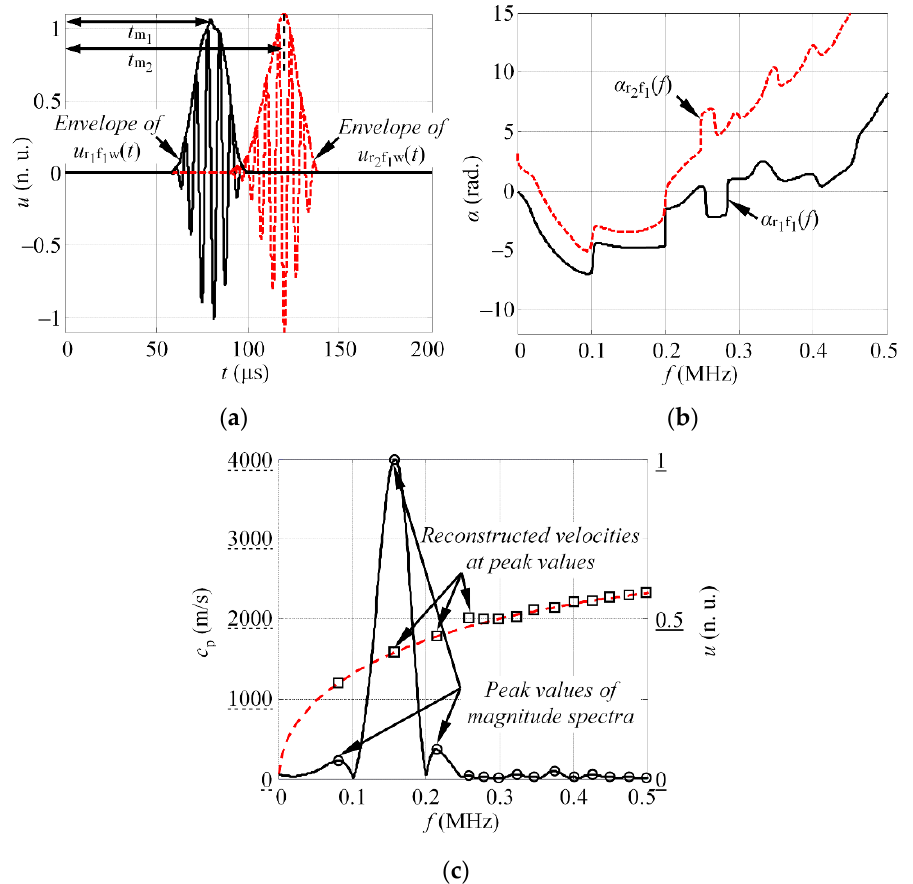
Figure 2. ( a ) The illustration of the shift of waveform in time domain to the maximum value of the Hilbert envelope; ( b ) the phase spectra of the waveforms, registered at distances d 1 and d 2 ; ( c ) the normalized magnitude spectra of the waveform, captured with receiver r 1 with the local maximum frequency values (circle markers), at which the phase velocity values are estimated (square markers) (dashed line represents the theoretical DC).